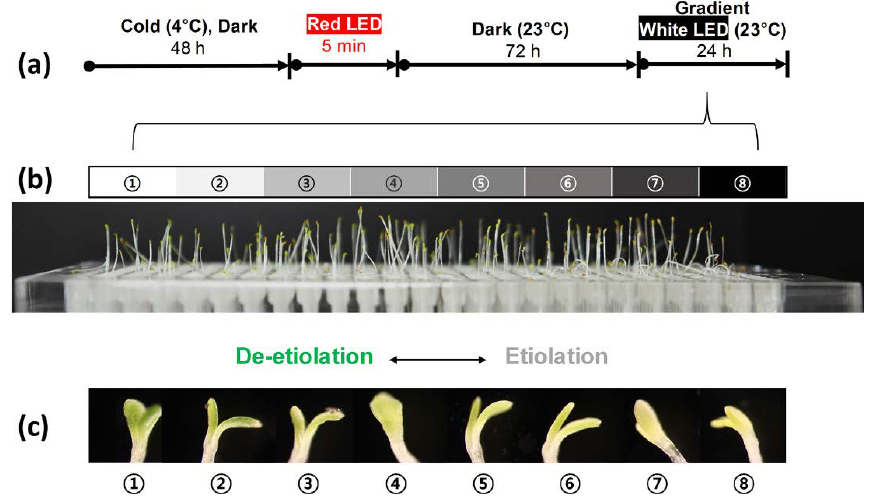
Figure 4. E ff ect of the white light on the etiolation, as observed with a light gradient module. ( a )